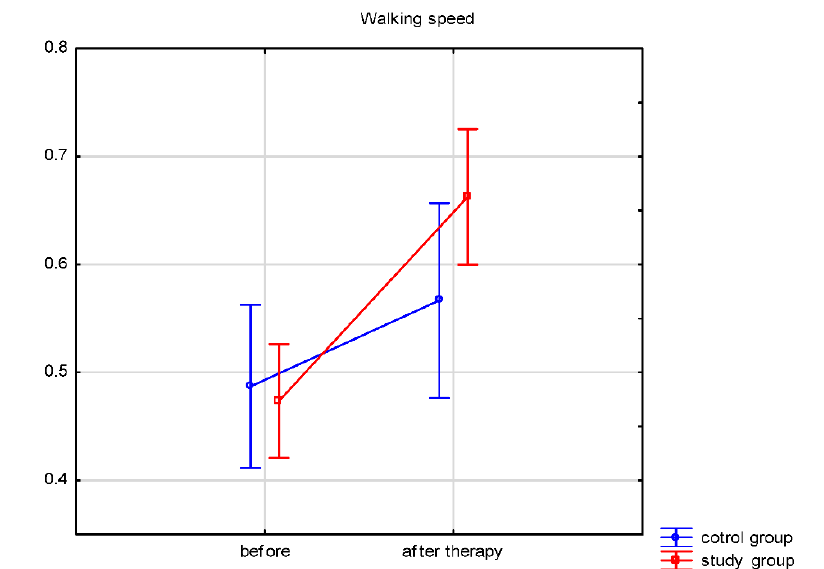
Figure 3. Distance before and after therapy. Additionally, the Romberg Test-assessed body balance significantly improved for patients in both the study ( p < 0.001) and the control ( p = 0.006 ) groups. Although gait quality improved in both groups, only the study group participants showed a statistically significant ( p < 0.001) walking base refinement. Furthermore, the number of patients re- quiring a walking aid significantly decreased ( p = 0.006) in both groups (Table 4). Table 4. Functional gait variables. Variable